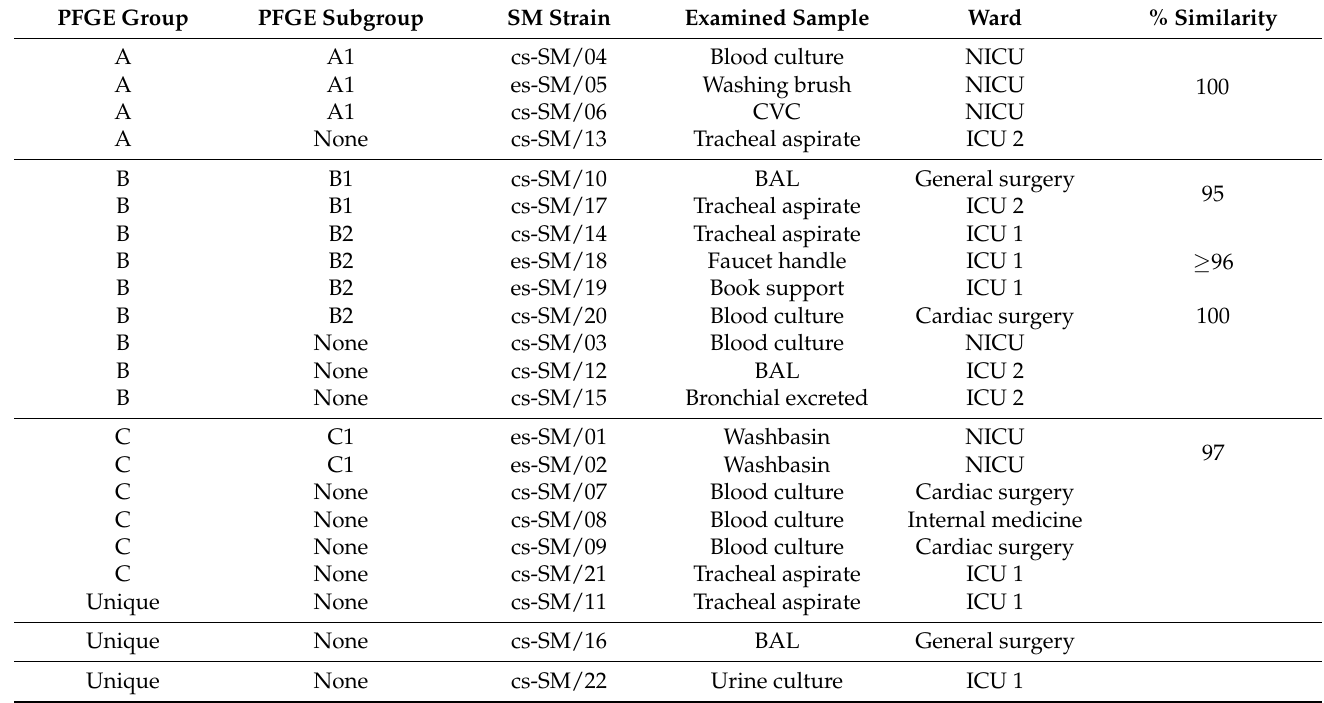
Table 2. PFGE grouping and % similarity of clinical and environmental strains of Serratia marcescens according to sample and